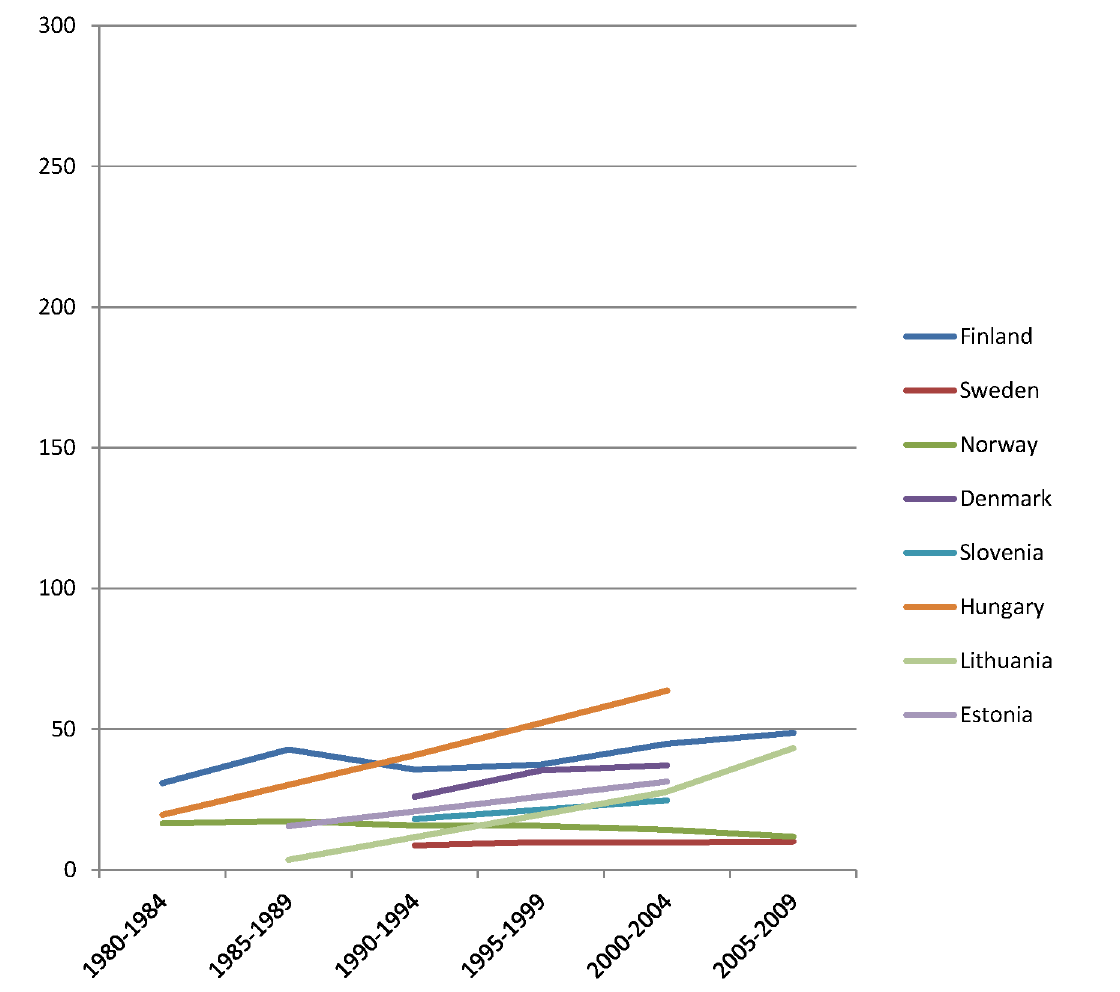
Fig 3. Trends in age-adjusted mortality from alcohol-related causes among men aged 35 – 79 y in the high education group in Northern and Eastern European countries, ca. 1980 – 2010, by country. The y-axis shows age-adjusted alcohol-related mortality in deaths per 100,000